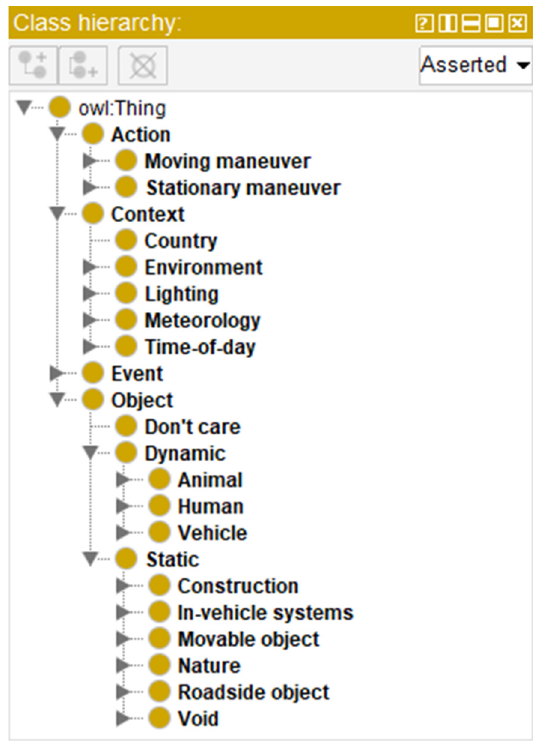
Figure 4. Taxonomy tree in Protégé showing the main hierarchy of classes in the ontology.